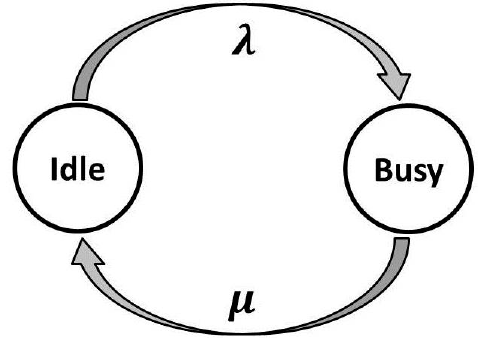
Figure 4. An example of irrational involvement of licensed channels.